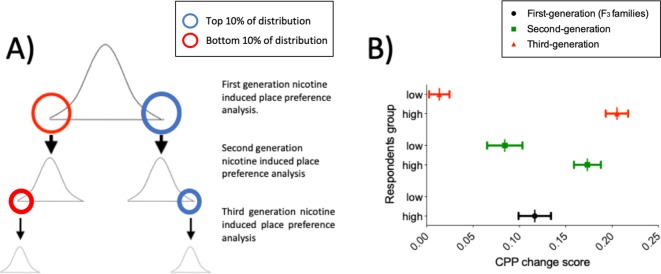
Nicotine CPP is heritable.(A) Breeding and selection to assess heritability of nicotine-induced place preference in ENU-mutagenized zebrafish. To test whether nicotine preference is heritable, fish in the upper (blue circle) and lower (red circle) 10% of the change in preference distribution curve were inbred and screened for CPP (Second generation CPP assay). A similar approach was used for the third generation CPP assay. (B) CPP for nicotine is heritable. Mean preference change is increasingly distinct for the second and third generation CPP analysis. Plot represents mean and ± SEM. First generation (corresponding to the F3 families used for the screen) (n = 120): mean = 0.11; SD = 0.17. Second generation: Offspring of fish from upper 10% of the first generation screen (n = 92): mean = 0.17; SD = 0.14. Offspring of fish from lower 10% of the first generation screen (n = 64): mean = 0.08; SD = 0.15. Third generation. Offspring of fish from upper 10% of the second generation screen (n = 69): mean = 0.21; SD = 0.10. Offspring of fish from lower 10% of the second generation screen (n = 67): mean = 0.01; SD = 0.09.Figure 2—source data 1.Nicotine CPP over three generations.